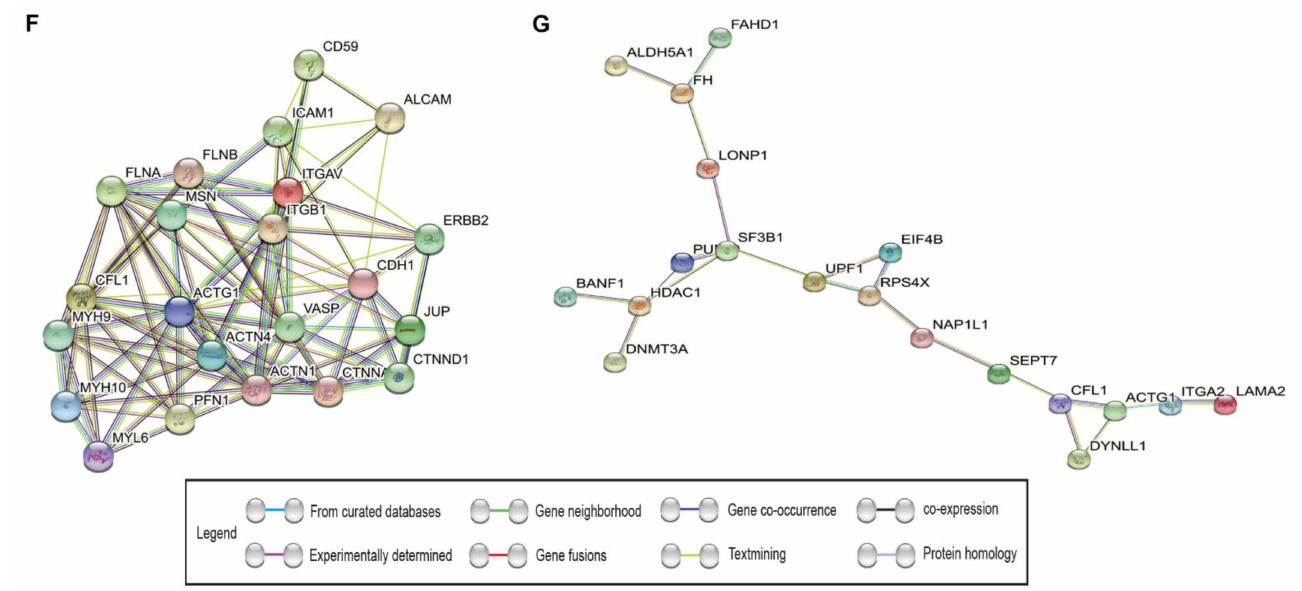
Figure 3. Proteomaps and top pathway analysis of increased proteins with a relative fold change higher than 2 (0.5 < FC > 2) for the ratio HCC-1954 ME/MCF-7 ME. ( A , C ) show the biological processes analysed for HCC-1954 and MCF-7, respectively. ( B , D ) show the proteins classified in each case. ( E ) Top pathways of ME fraction protein classification from HCC-1954 and MCF-7 performed with the Kegg Mapper platform. Interaction networks of proteins increased ( F ) in HCC-1954 ME and ( G ) in MCF-7 ME. HCC-1954 with a PPI enrichment p -value of < 1.0 × 10 − 16 and MCF-7 with a PPI enrichment p -value of 4.48 × 10 − 5 ,